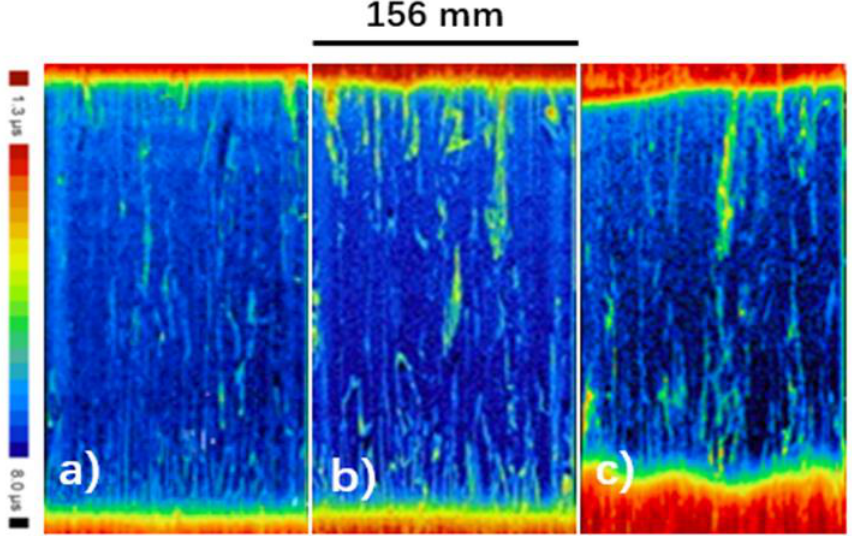
Figure 3. Minority carrier lifetime mappings of blocks assisted by ( a ) electrophoretic deposited quartz powder, ( b ) spray quartz powder, and ( c ) silicon particles.